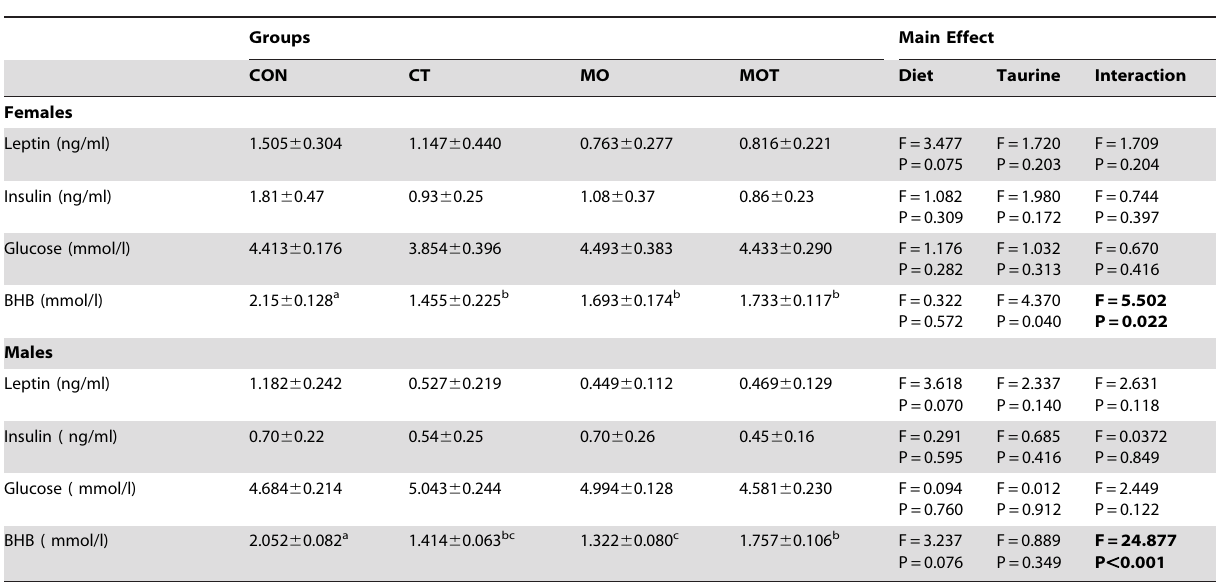
Values are presented as mean 6 SEM, n=7–9 per group. Bold font indicates effect P value , 0.05 via two-way ANOVA, main effects were not indicated when a significant interaction was determined. Lower case letter superscripts ( a,b,c ) indicate multiple comparison procedures were conducted for diet and taurine interaction. Groups that do not share the same letter are significantly different from each other (p , 0.05).